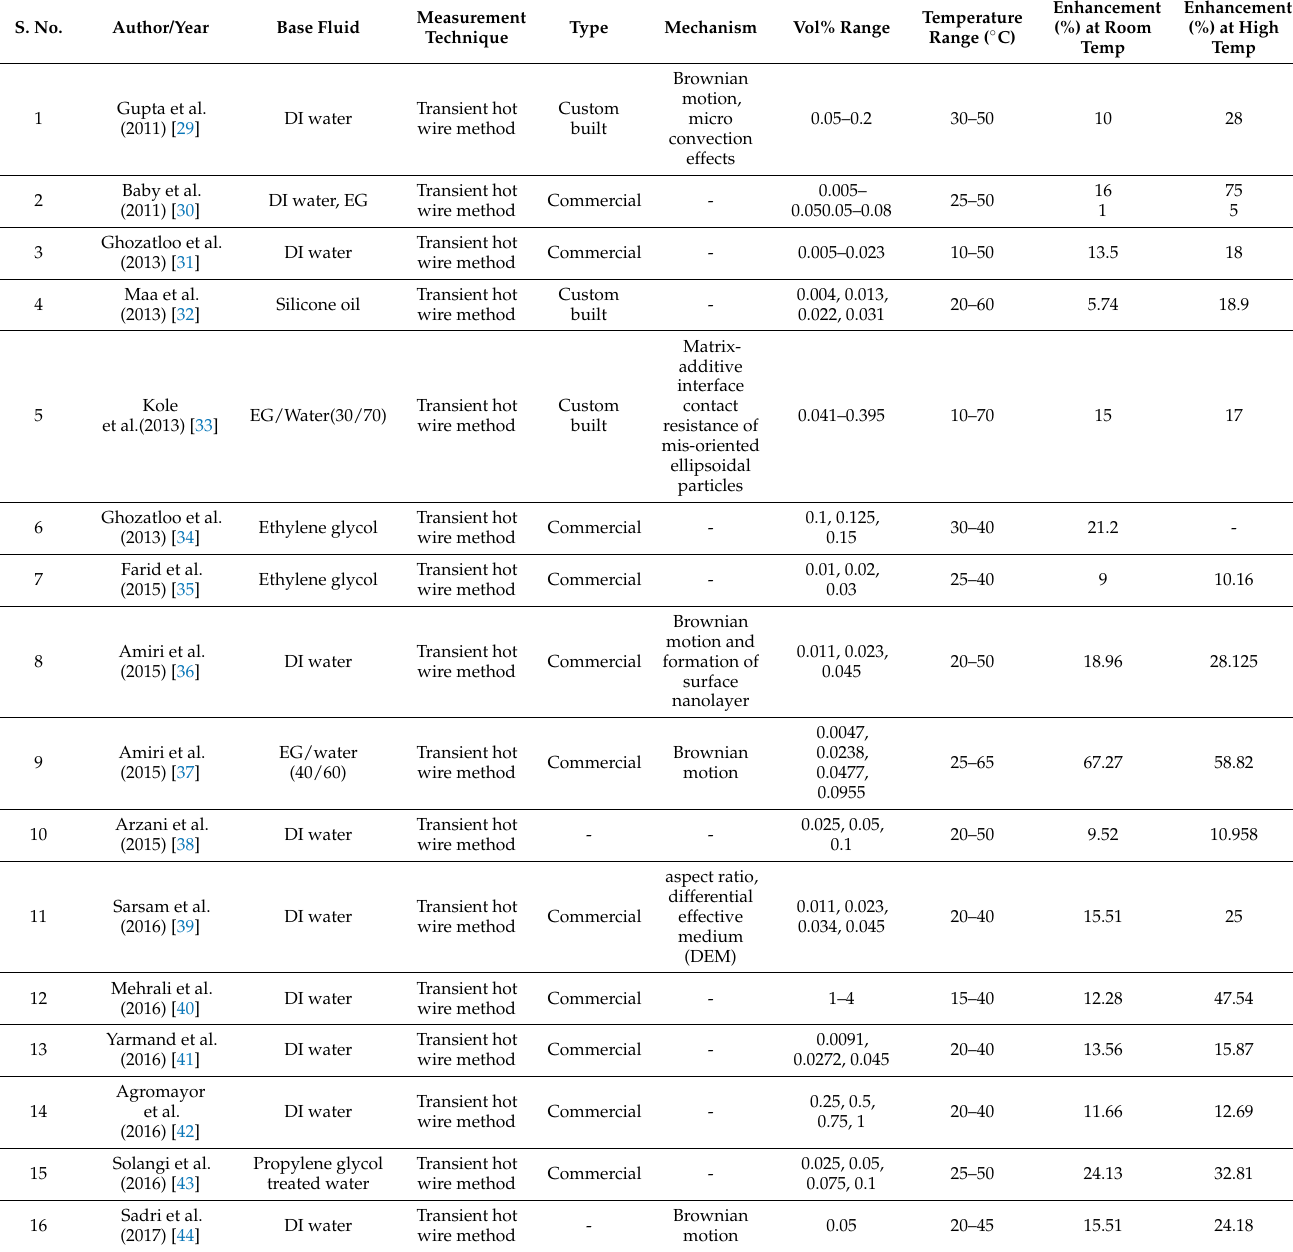
Table 7. Summary of published literature on thermal conductivity of graphene-based